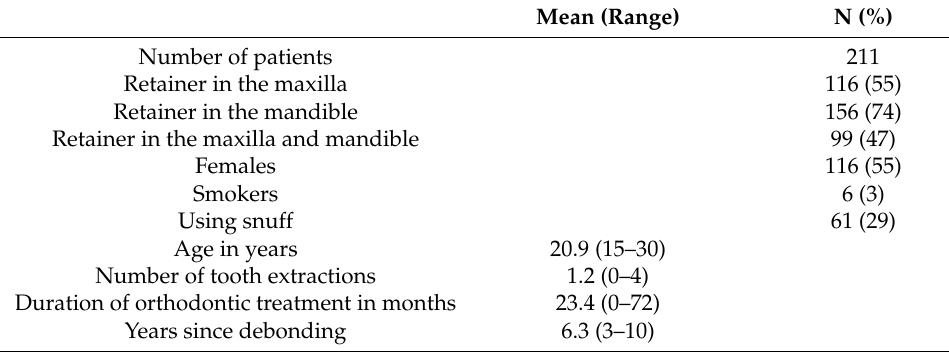
Table 1. Patient demographics [21].